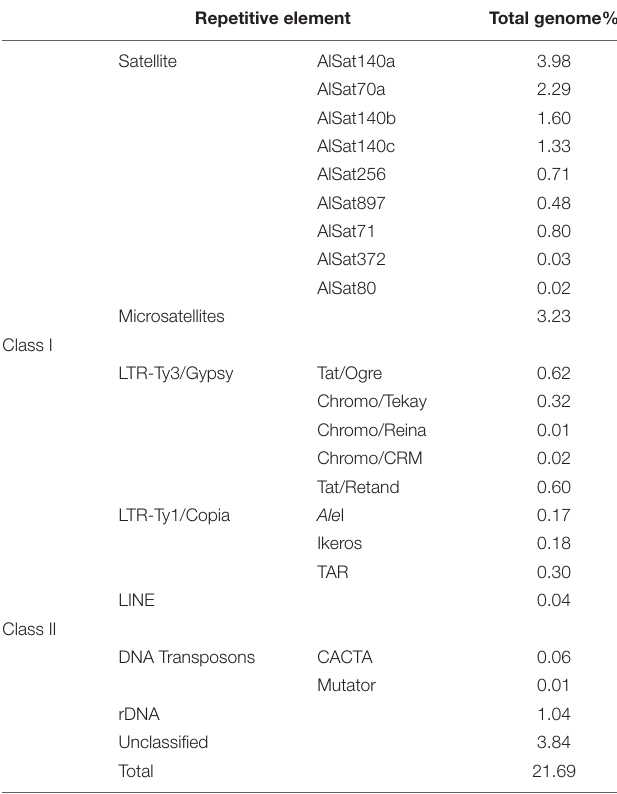
TABLE 2 | Genome proportion of the repetitive elements identified in A. littoralis . Repetitive